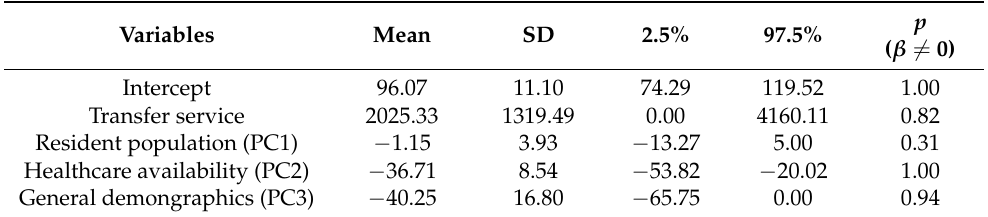
Table 3. The regression coefficients of transfer service and principal components of the socioeconomic indicators in the Bayesian multivariate